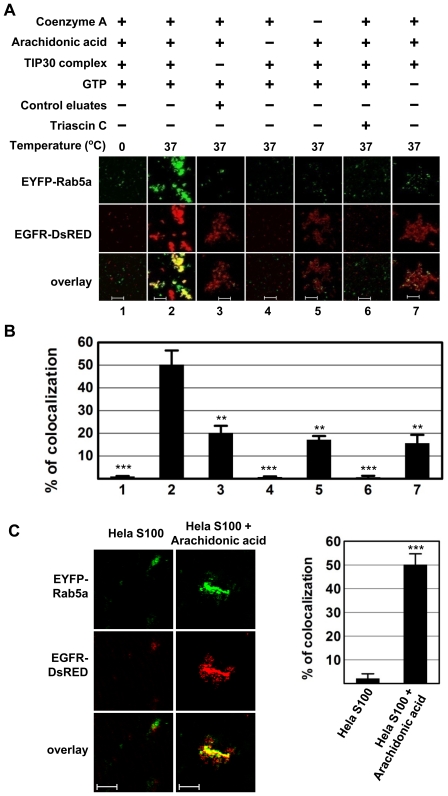
The TIP30 protein complex, arachidonic acid and coenzyme A promote the fusion between endocytic and Rab5a vesicles.(A) Aliquots of isolated EGFR-DsRed and EYFP-Rab5a vesicles (both contain 20 µg of proteins) were mixed and incubated in reactions (20 µl) with the indicated components. The resulting fusion products were spotted on glass slides and images were taken using confocal microscope. Panels 1, 4 and 6 were scanned with 3× amplification gain setting due to lower fluorescence intensity of individual vesicles. Arachidonic acid (100 nmol) was used in the reactions. Images are single plane and are representative for at least three independent experiments. Scale bars, 5 µm. (B) Signal overlap was quantified using MBF_ImageJ. Pearson's colocalization coefficients were calculated from three independent experiments and were converted to percentages. Data represent means ± SEM. **P<0.01, ***P<0.001; t test. (C) Arachidonic acid promotes the vesicle fusion induced by HeLa cell S100. S100 fractions (4 mg/ml) of HeLa cells were incubated with isolated EGFR-DsRed and EYFP-Rab5a vesicles (both contain 20 µg proteins) in the absence or presence of 100 nmol arachidonic acid. Resulting vesicles were examined using confocal microscopy (left panel) and fluorescence overlaps were quantified (right panel).